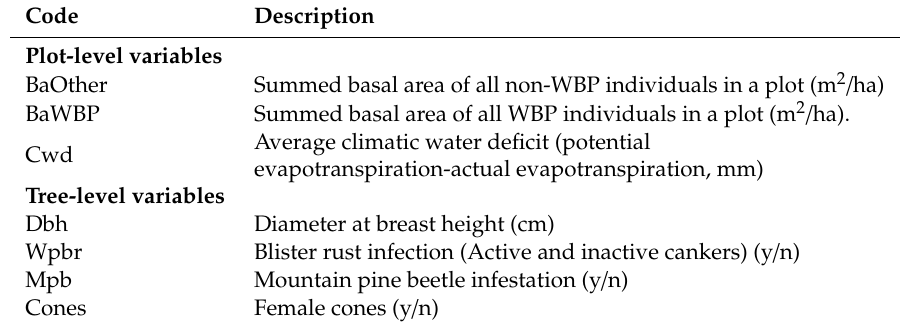
Table 1. Plot- and tree-level variables included in generalized linear mixed-e ff ects models (GLMMs) conducted for all dependent variables in two parks Crater Lake and Lassen Volcanic National Parks. The acronyms WBP, stands for whitebark